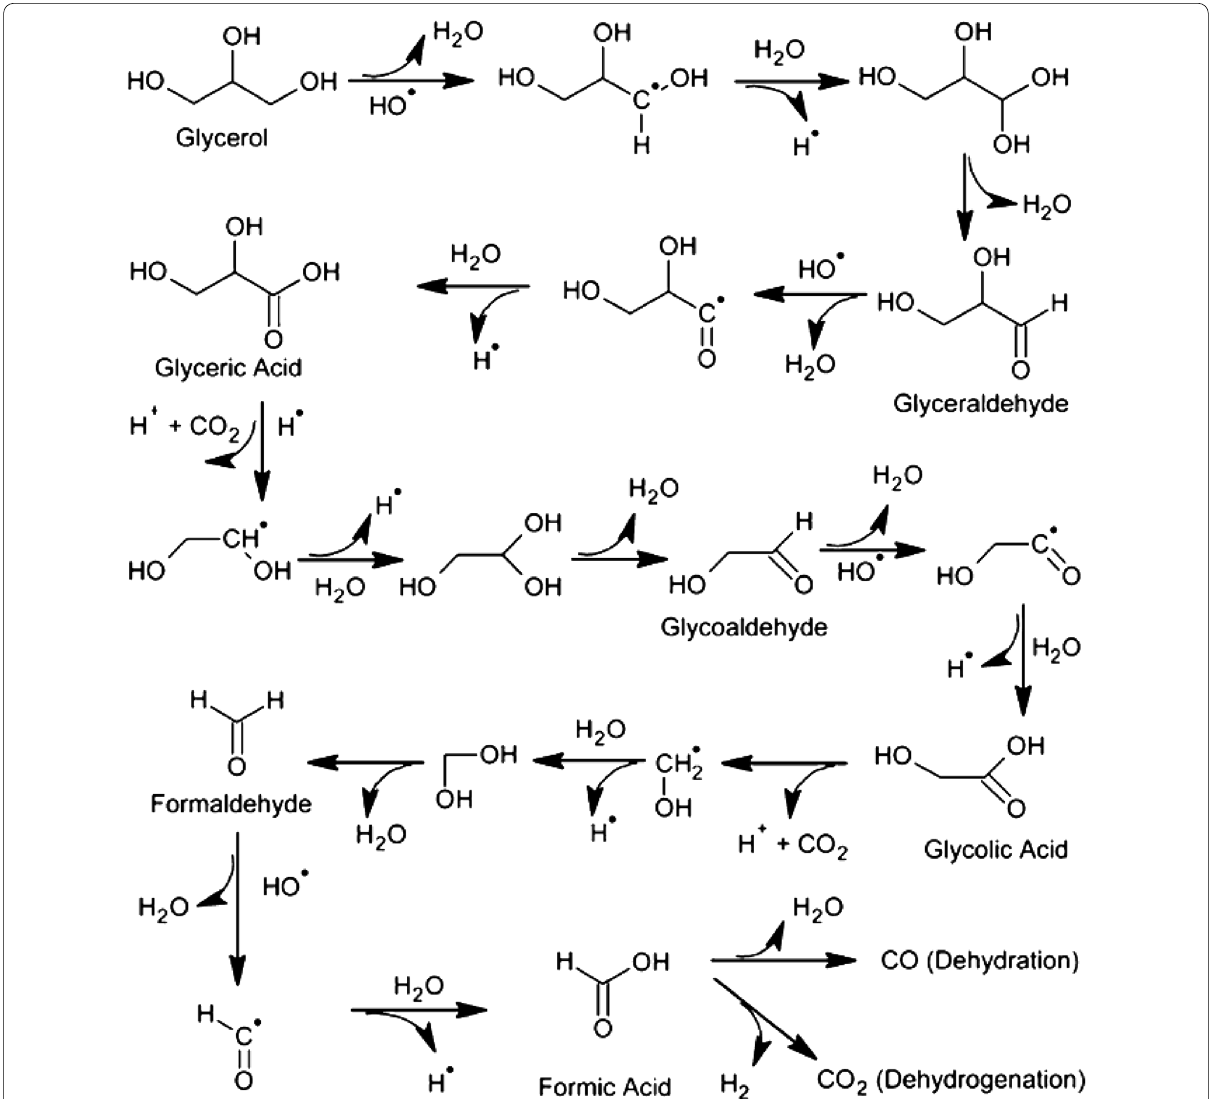
Fig. 10 Photoreformation pathway for hydrogen production from glycerol biomass derivative. Reprinted with the permission from Puga et al. [5] (Copyright 2016